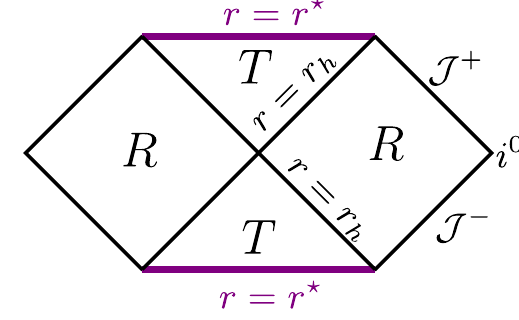
Fig. 1 Carter–Penrose diagram for case q = 2 , 4 , 6 ,...